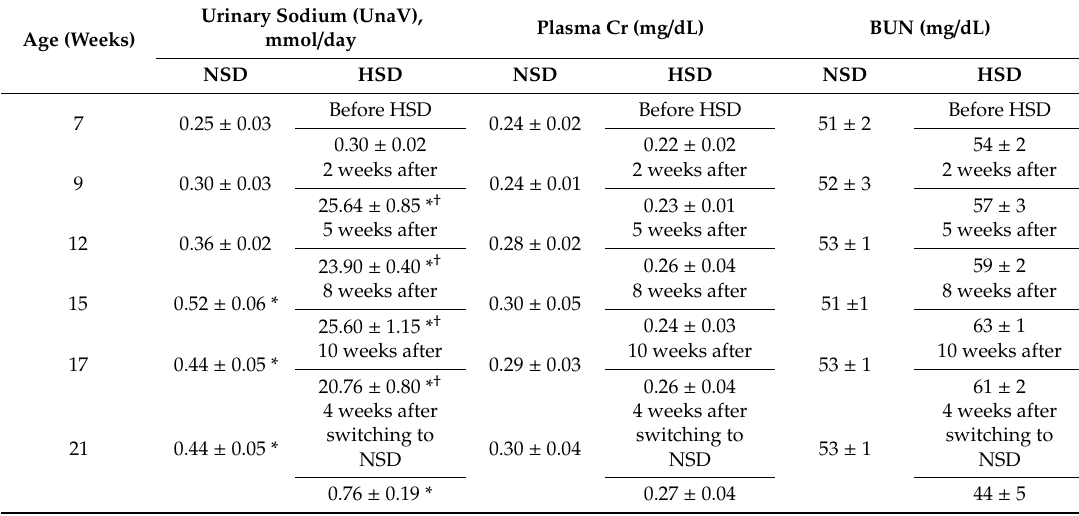
Table 1. Urinary excretion rate of Na, plasma Cr, and BUN concentration in DSS rats. Age